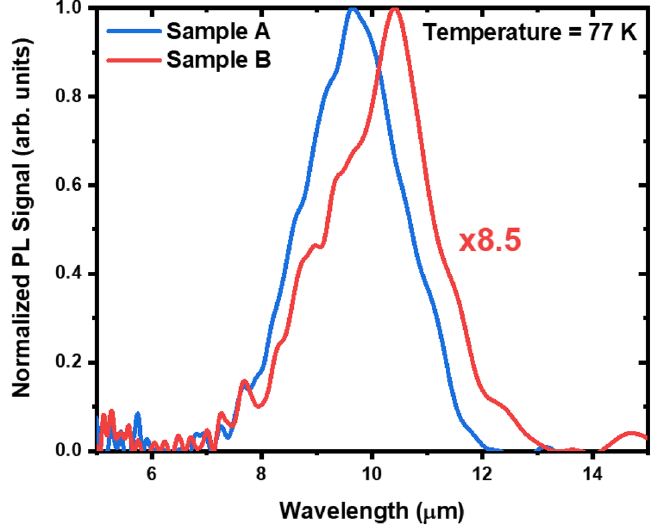
Figure 1. Normalized PL comparison at 77 K for Samples A and B.